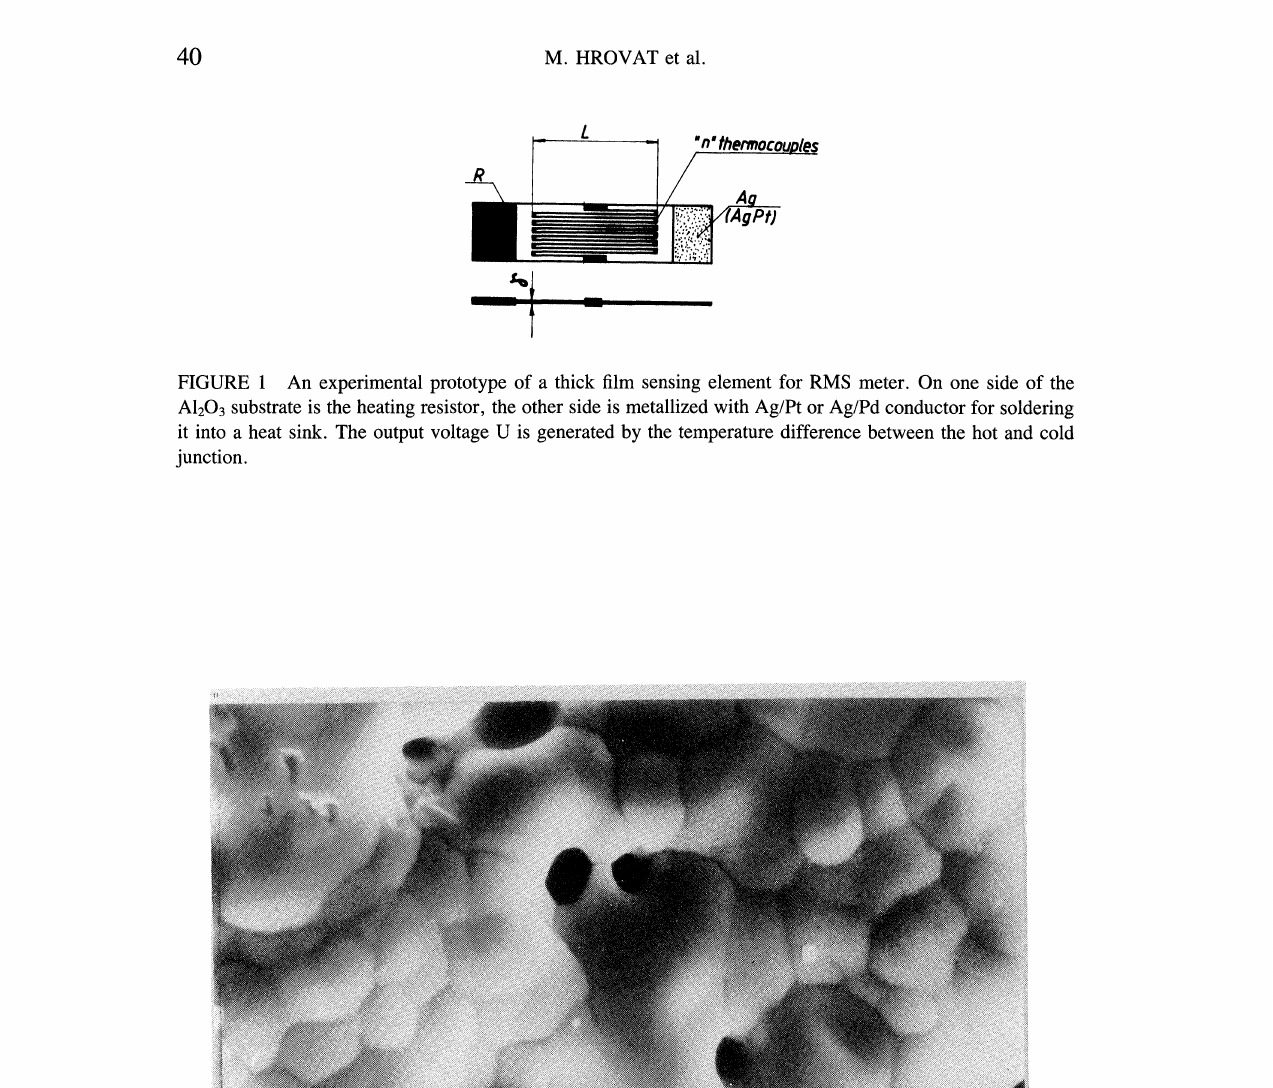
FIGURE 2 Microstructure of gold paste, fired at 850C, x